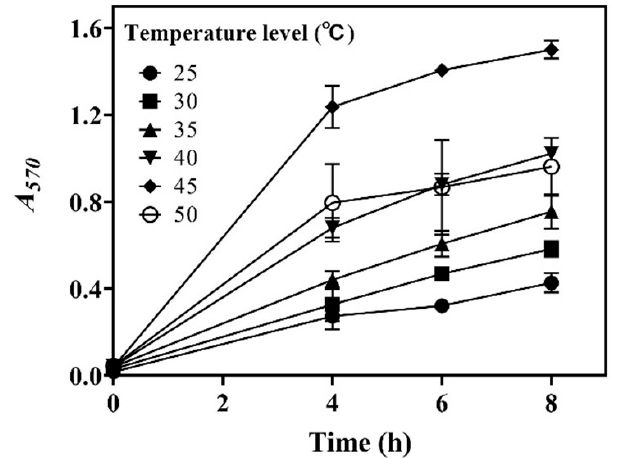
Figure 3. Effects of temperature on whole-cell catalysis. The relative content of GABA is expressed as A 570 ( n = 3). A 570 , absorbance at 570 nm.